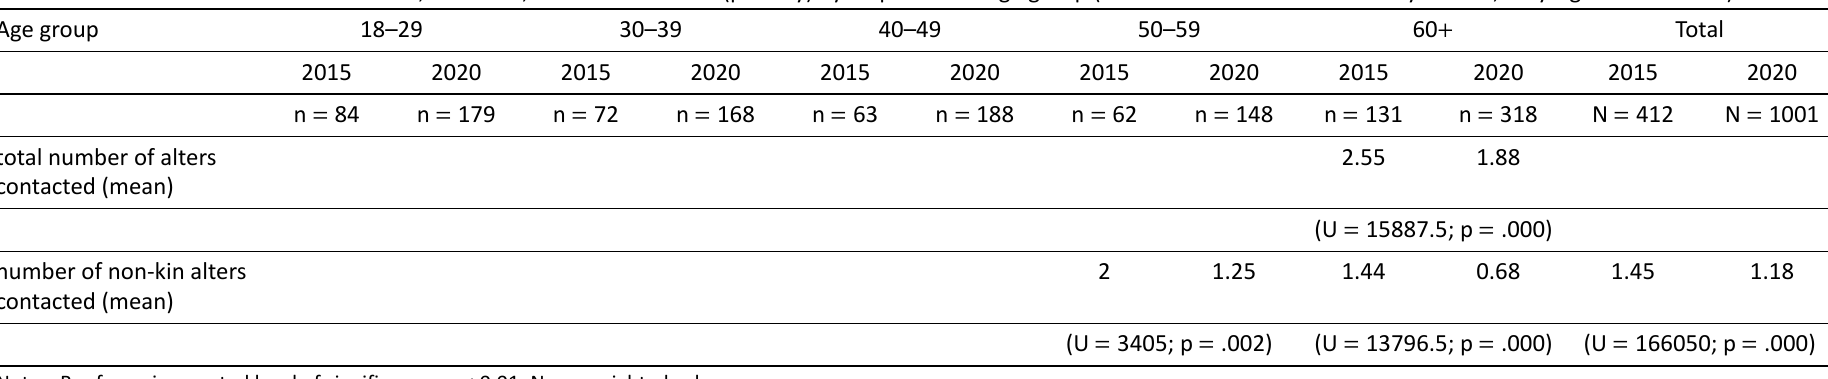
Table 4. Mean number of contacted alters, kin alters, and non‐kin alters (per day) by respondents’ age group (with Bonferroni Mann‐Whitney U tests; only significant